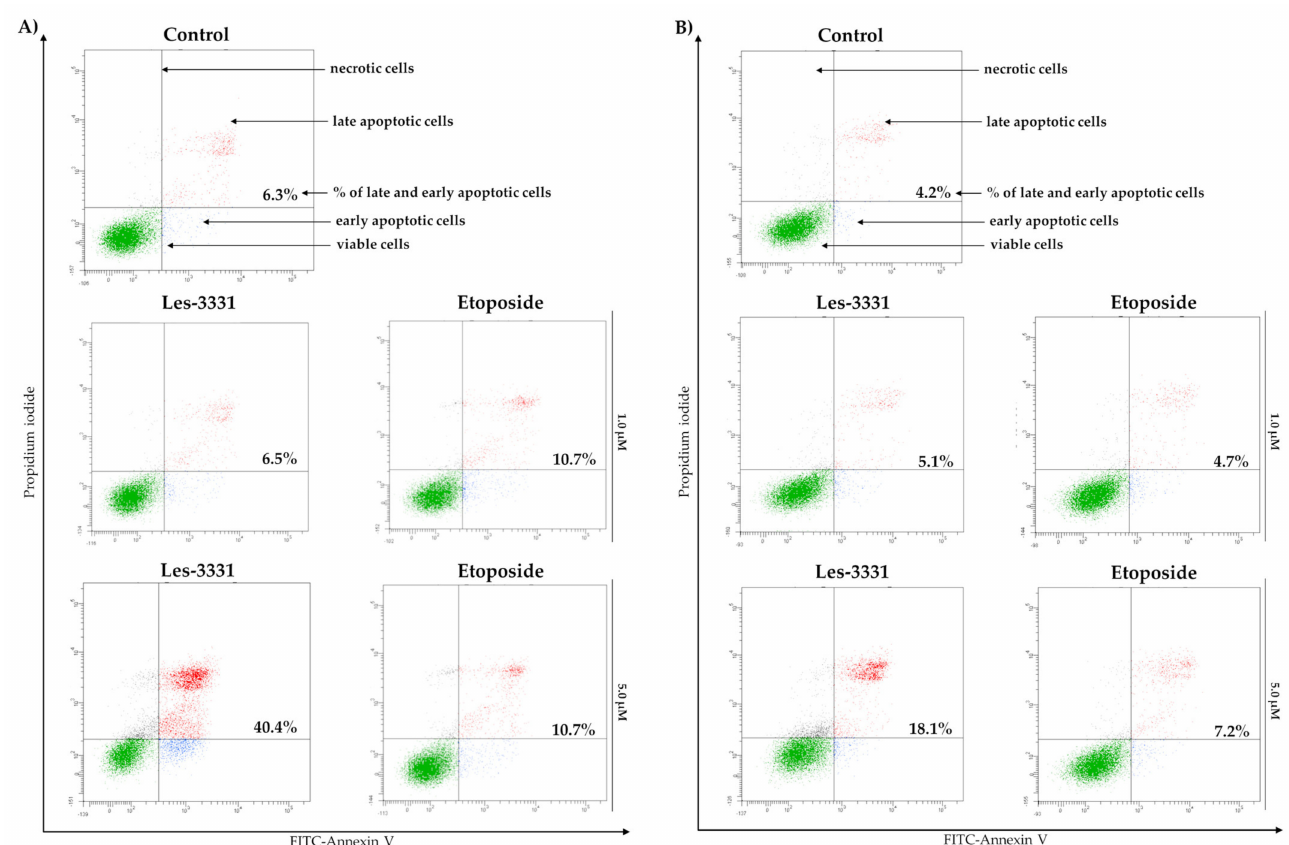
Figure 4. Induction of apoptosis in MCF-7 ( A ) and MDA-MB-231 ( B ) cells incubated with Les-3331 and a reference drug (etoposide) at 1 µ M and 5 µ M concentration for 24 h. The total number of late and early apoptotic human breast cancer cells is presented as the mean percentage from three independent experiments performed in